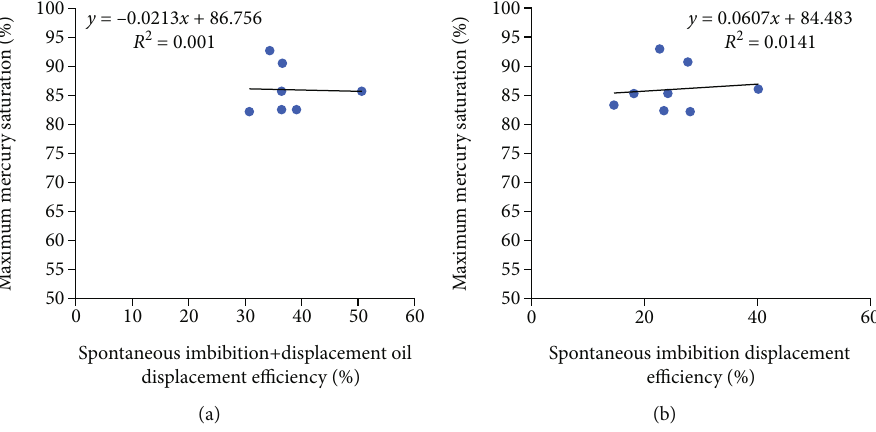
Figure 8: Correlation between oil displacement e ffi ciency and maximum mercury saturation.